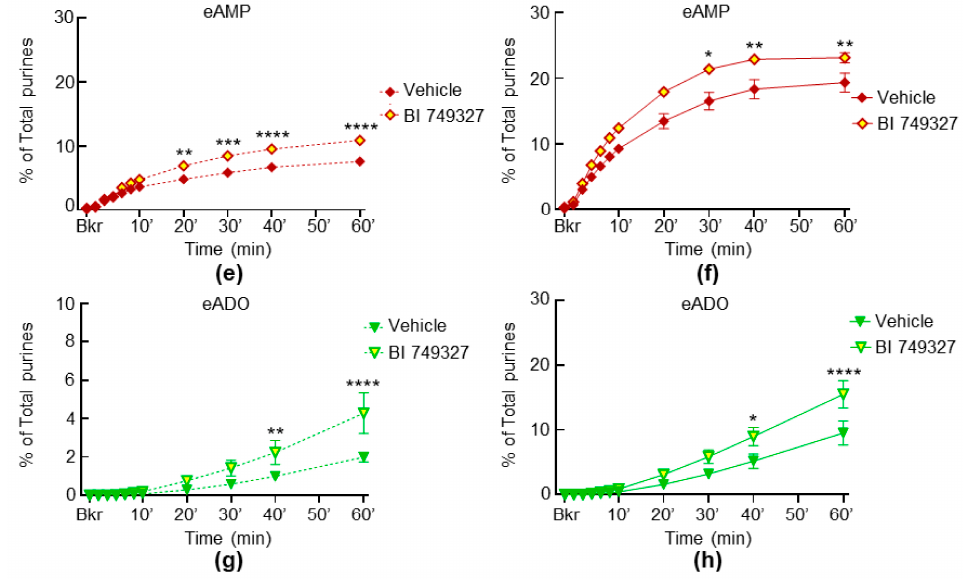
Figure 7. Effects of BI 74932 on the hydrolysis of eATP by s-ENTDs released in cELS of nondistended and distended detrusor-free bladder preparations. Changes in eATP, eADP, eAMP and eADO in the presence of vehicle (DMSO 0.2%, n = 6) and BI 74932, 1 µM ( n = 3) in nondistended ( a , c , e , g ) and distended ( b , d , f , h ) bladder preparations; n , number of bladder preparations. eATP, eADP, eAMP and eADO are presented as percentages of total purines (eATP + eADP + eAMP + eADO) present in reaction solutions. Asterisks denote significant difference from vehicle controls. * p < 0.05, ** p < 0.01, *** p < 0.001, **** p < 0.0001. Two-way ANOVA with Sidak’s multiple comparisons tests.